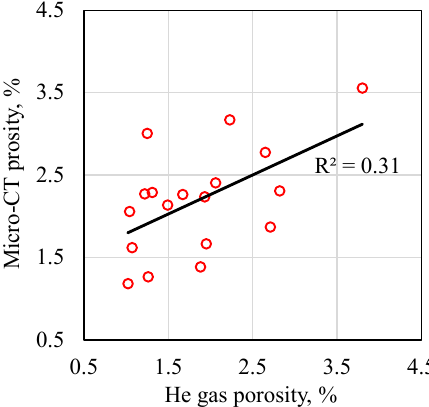
Figure 9. Cross plot of the micro-CT porosity against He gas filling porosity. It can be seen that the porosity acquired from micro-CT is close to that from He gas.